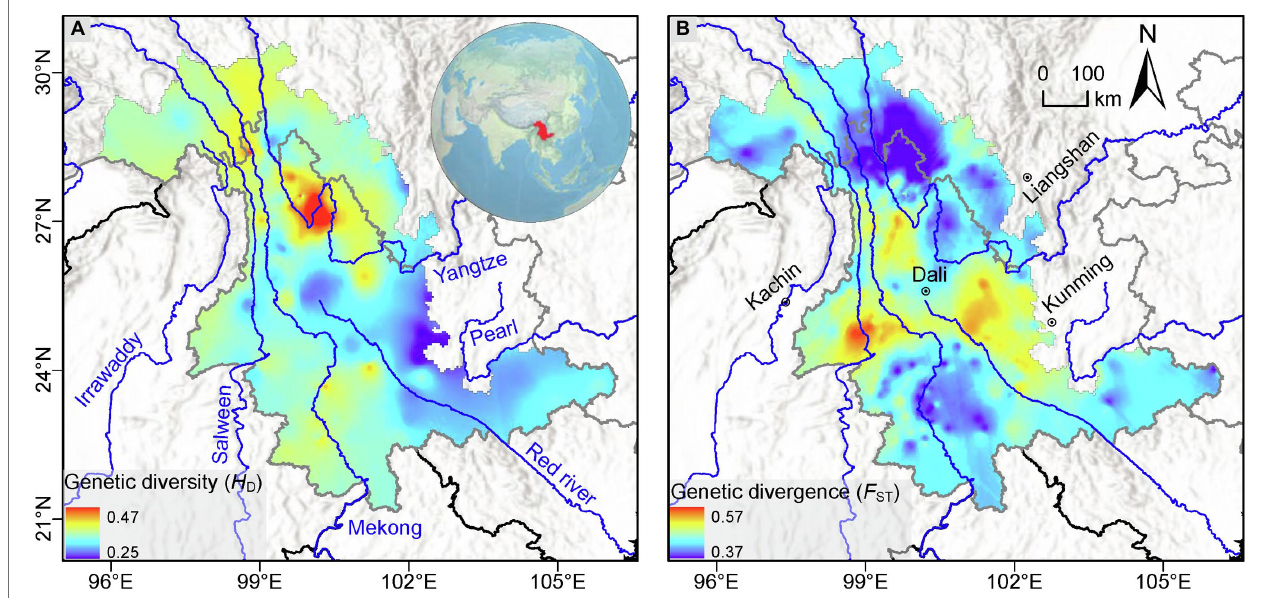
FIGURE 3 | Multi-species genetic landscapes for (A) genetic diversity based on haplotype diversity ( H D ) and (B) population pairwise genetic divergence ( F ST ). The major rivers in the region are represented by blue